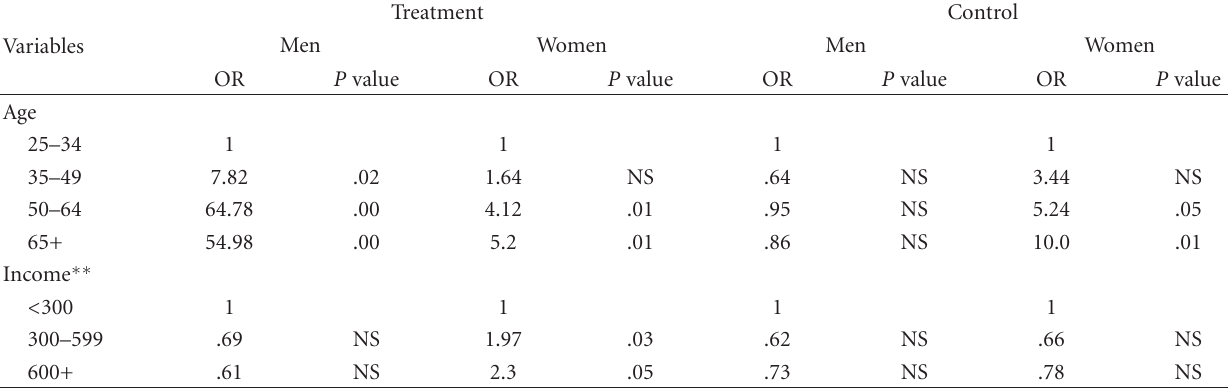
Table 3: Adjusted odds ratio (OR) and their P values of predictors of hypertension treatment and control by sex. Treatment